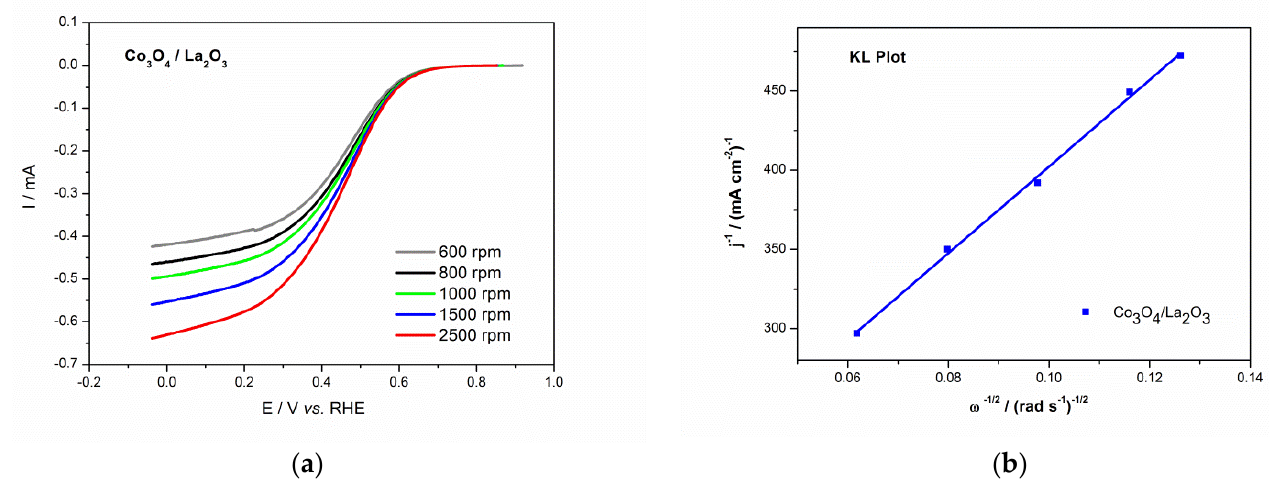
Figure 7. Reduction of O 2 at the Co-based electrode ( a , b ) KL plot for Co 3 O 4 /La 2 O 3 .